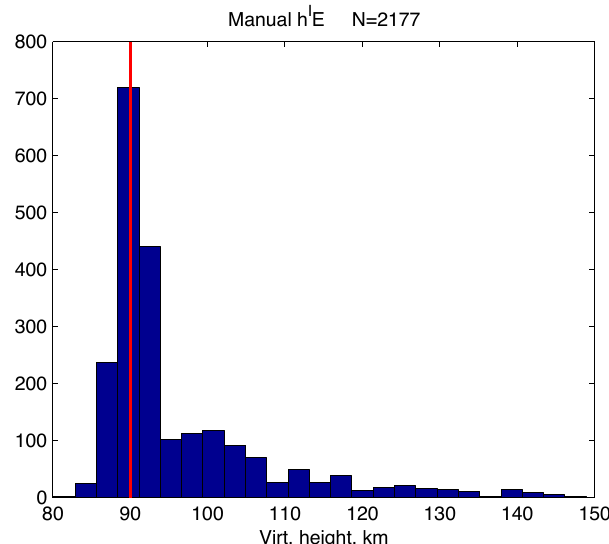
Figure 5. Distribution of h (cid:48) E scaled manually. The red line at 90km indicates the fixed height assumed in Autoscala. The mode of the manually scaled h (cid:48) E distribution is close to 90km as